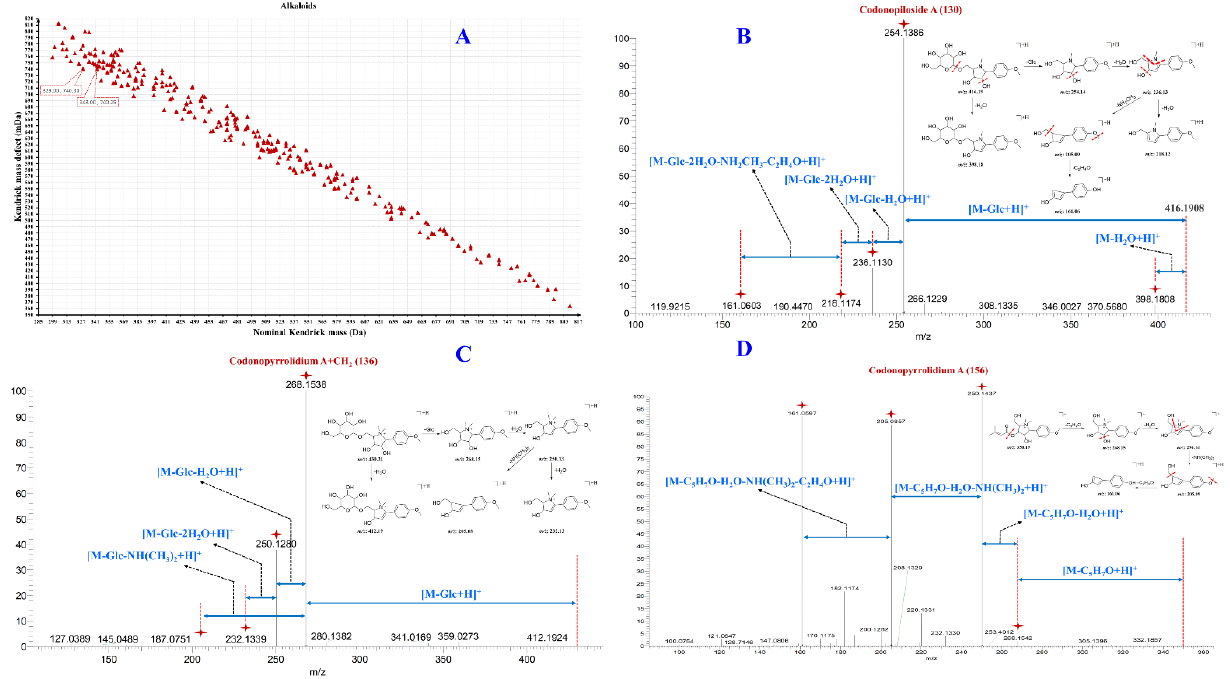
Figure 3. The KMDF scatter plot depicted the m / z values of potential alkaloids in SFI after PMDF treatment in Shenqi Fuzheng Injection (SFI) and the MS/MS spectra of the representative alkaloids and possible MS fracture patterns. (( A ), KMDF scatter plot of potential alkaloids; ( B ), codonopiloside A; ( C ), codonopiloside A + CH 2 ; ( D ), codonopyrrolidium A). Compounds 153 and 158 are a pair of isomers and m / z 350.20 Da [M + H] + ions were observed in positive ion mode. Through comparison with MS data from the literature,